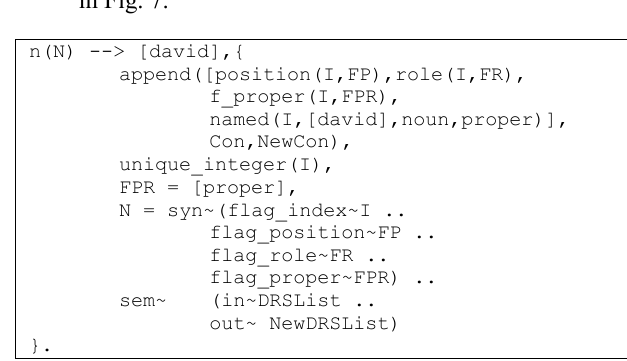
Figure 7. Describe proper noun “David” (example 1) in first three groups based on framework GULP